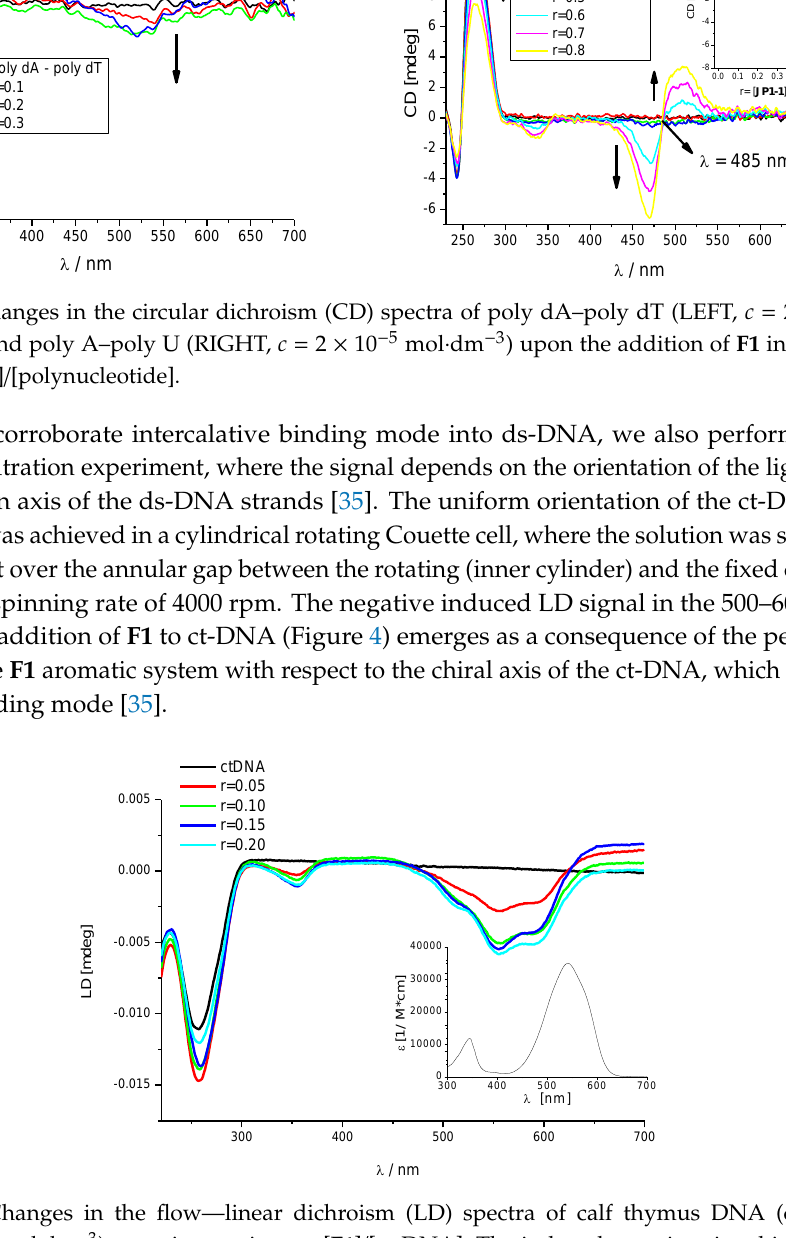
Figure 4. Changes in the flow—linear dichroism (LD) spectra of calf thymus DNA (ct-DNA) ( c = 2 × 10 −4 mol·dm −3 ) at various ratios r = [ F1 ]/[ct-DNA]. The induced negative signal in the LD spectra corresponds to the absorption band of F1 , the inset shows F1 UV/vis absorption spectrum.